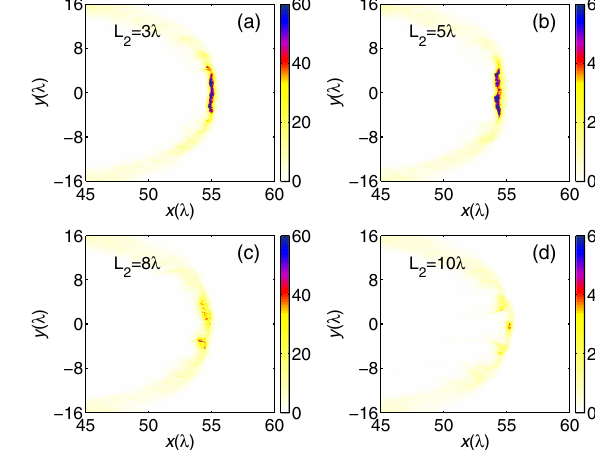
FIG. 8. The spatial density (normalized by n c ) distributions of the proton with different pulse widths of the auxiliary laser. The pulse width of the auxiliary laser L 2 ¼ 3 λ in (a), L 2 ¼ 5 λ in (b), L 8 λ in (c), and L 10 λ in (d), respectively. These snap- 2 ¼ 2 ¼ shots are corresponding to the moment t ¼ 42 T L